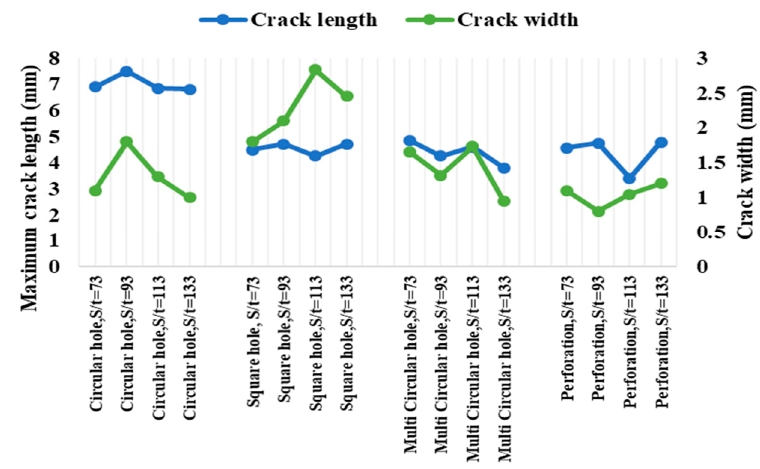
Figure 6. Crack dimensions of flexural failed specimens. Table 4. Numerical flexural performance measures.